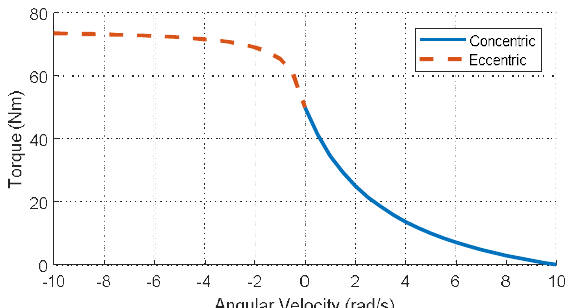
Figure 2. Torque-velocity scaling for concentric and eccentric